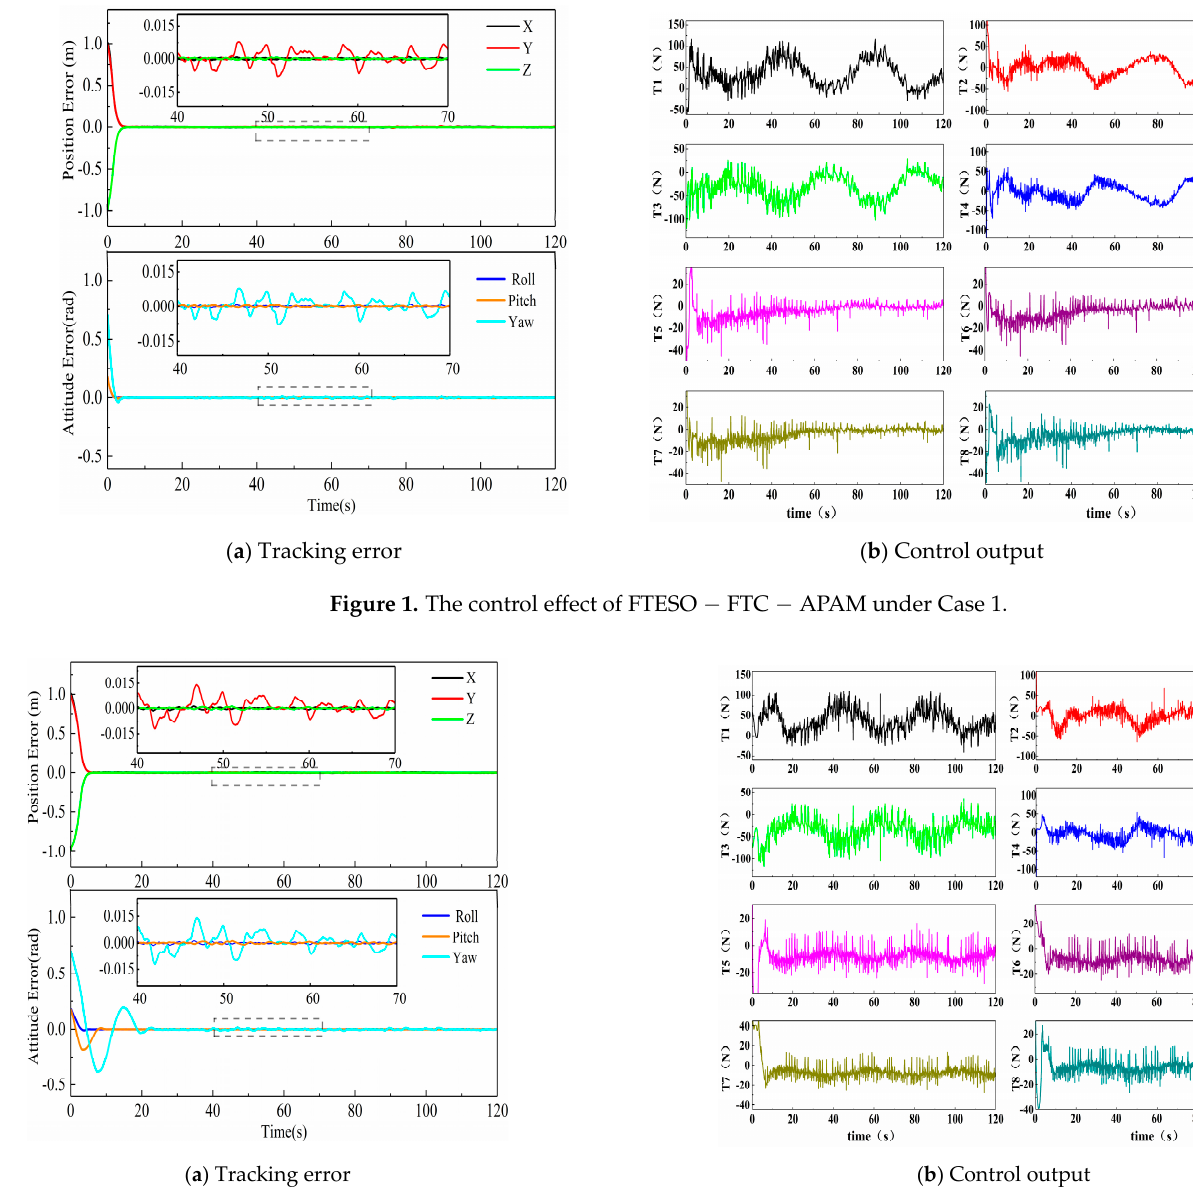
Figure 2. The control effect of FTESO − FTC under Case 1.